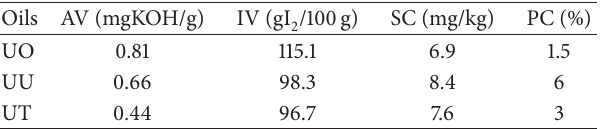
Table 3: Quality indicators of fresh, used, and treated oils. Oils AV (mgKOH/g)